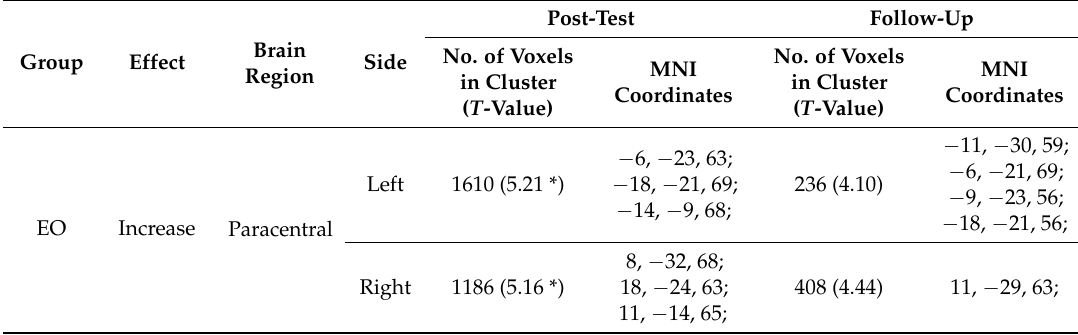
Table 4. MNI coordinates ( x , y , z ) of VBM-detected gray matter increases within the EO group from pre-test to post-test; * significant at FWE-corrected